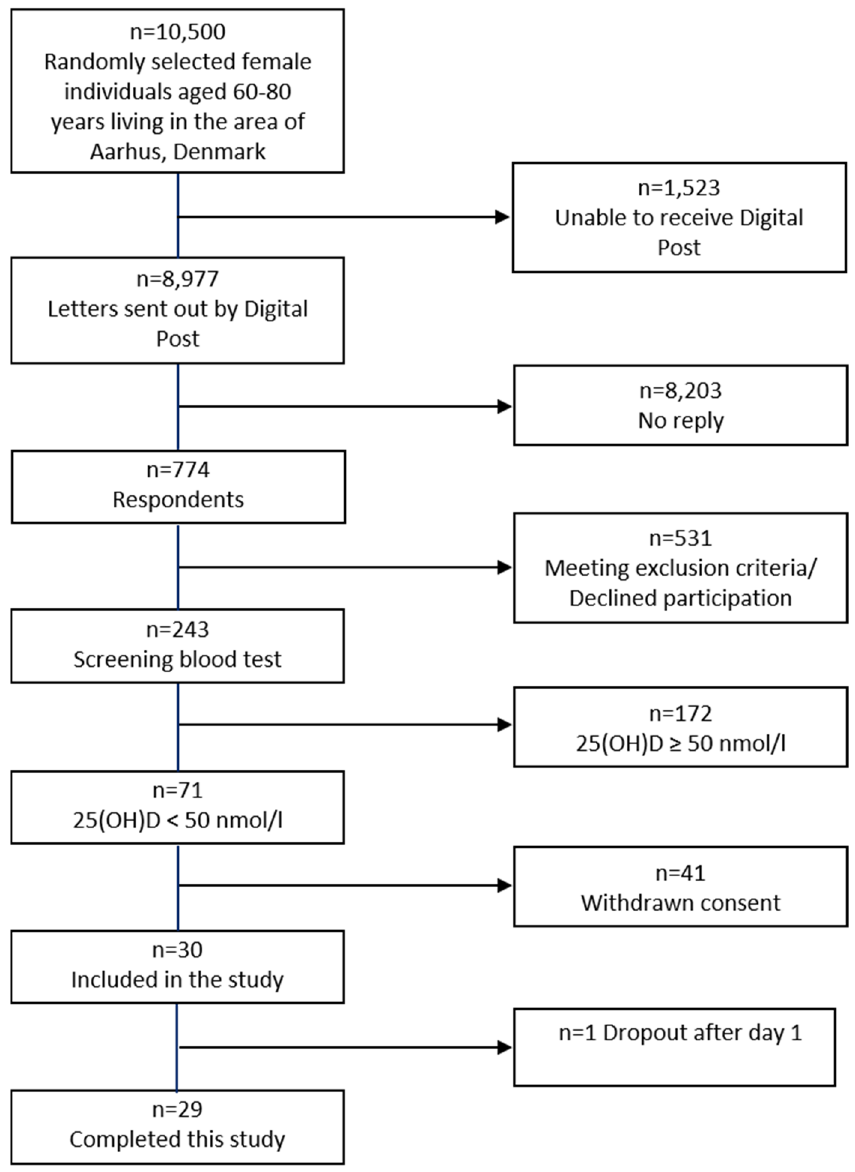
Figure 3. Flowchart of recruitment.